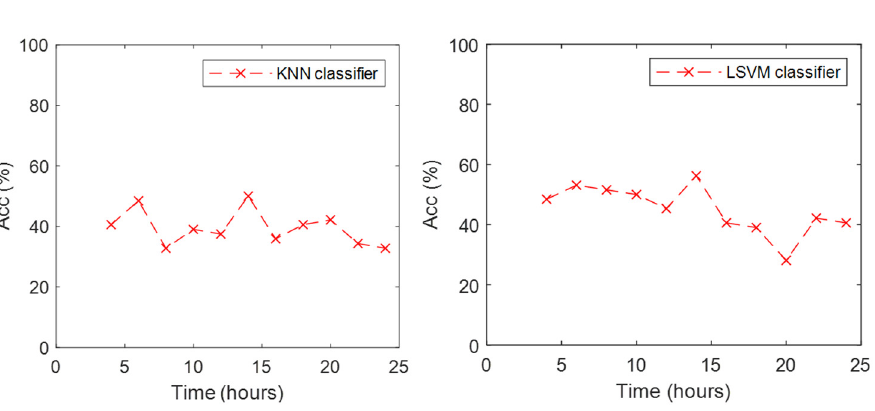
Figure 3. Accuracy of KNN ( left ) and LSVM ( right ) classifiers during the eleven trials.